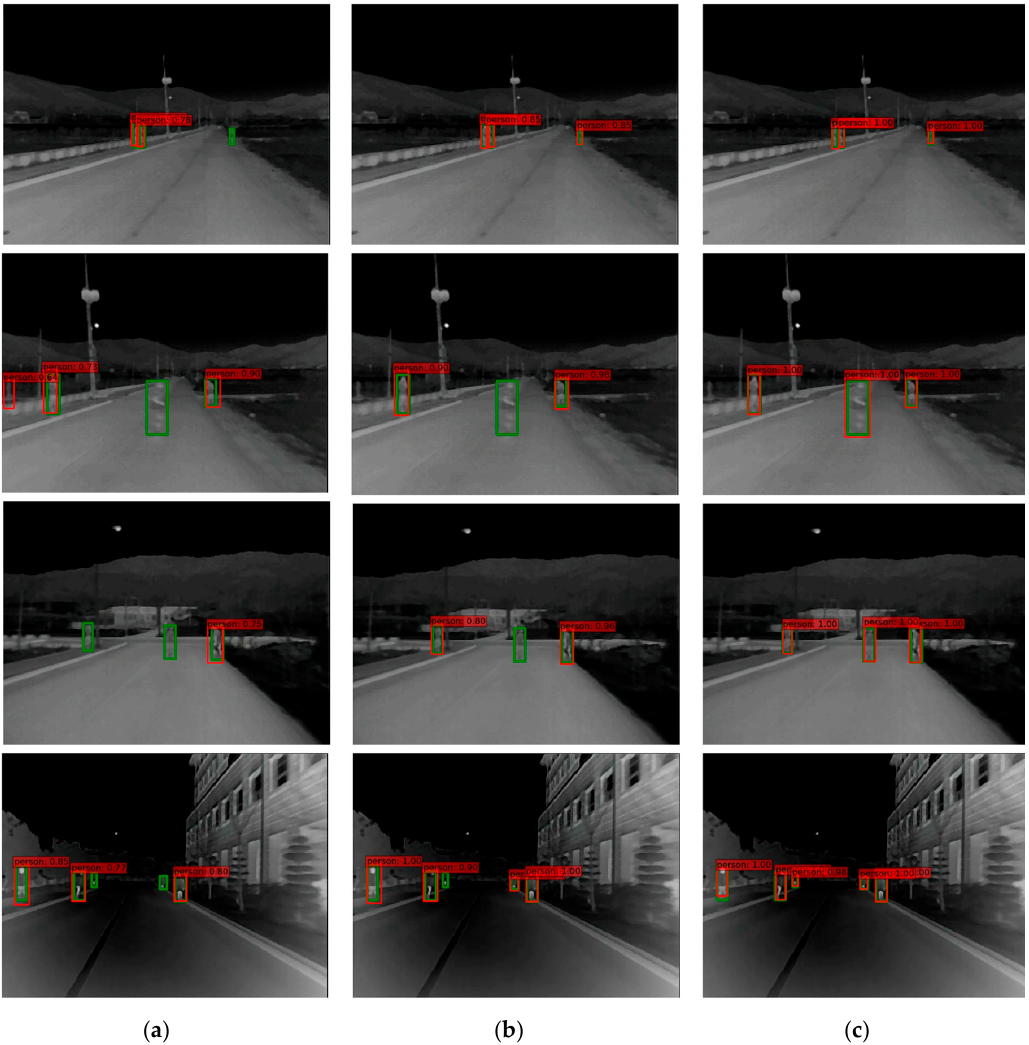
Figure 9. Visual comparisons of detection results on four example images among SSD, encoder-decoder module, and encoder-decoder + attention (AED-CNN). The green bounding boxes denote the ground truth. The red bounding boxes show the detection results. ( a ) SSD [16], ( b ) encoder-decoder module ( c ) encoder-decoder + attention (AED-CNN).